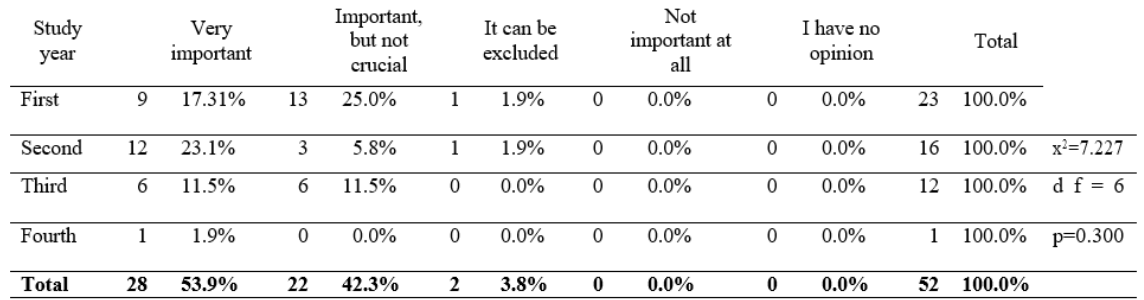
Table 10. Student’s attitudes about the importance of work on melodic in relation to the year of study